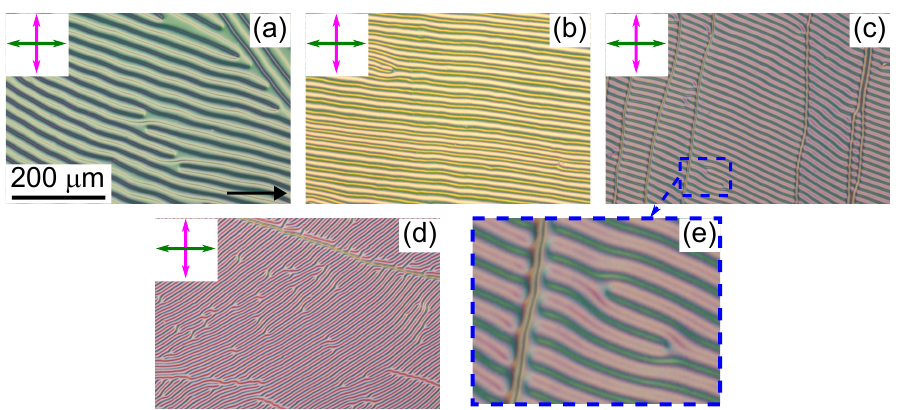
Figure 8. POM photos of cholesteric layers with confinement ratios d / p : 0.44 ( a ), 0.60 ( b ), 0.78 ( c ) and 0.88( d ). The magnified area of 100 × 70 µ m with two types of defects of periodic structure at d / p = 0.78 ( e ). POM photos ( a – d ) have the same scale. LC layer thicknesses are 6.5 µ